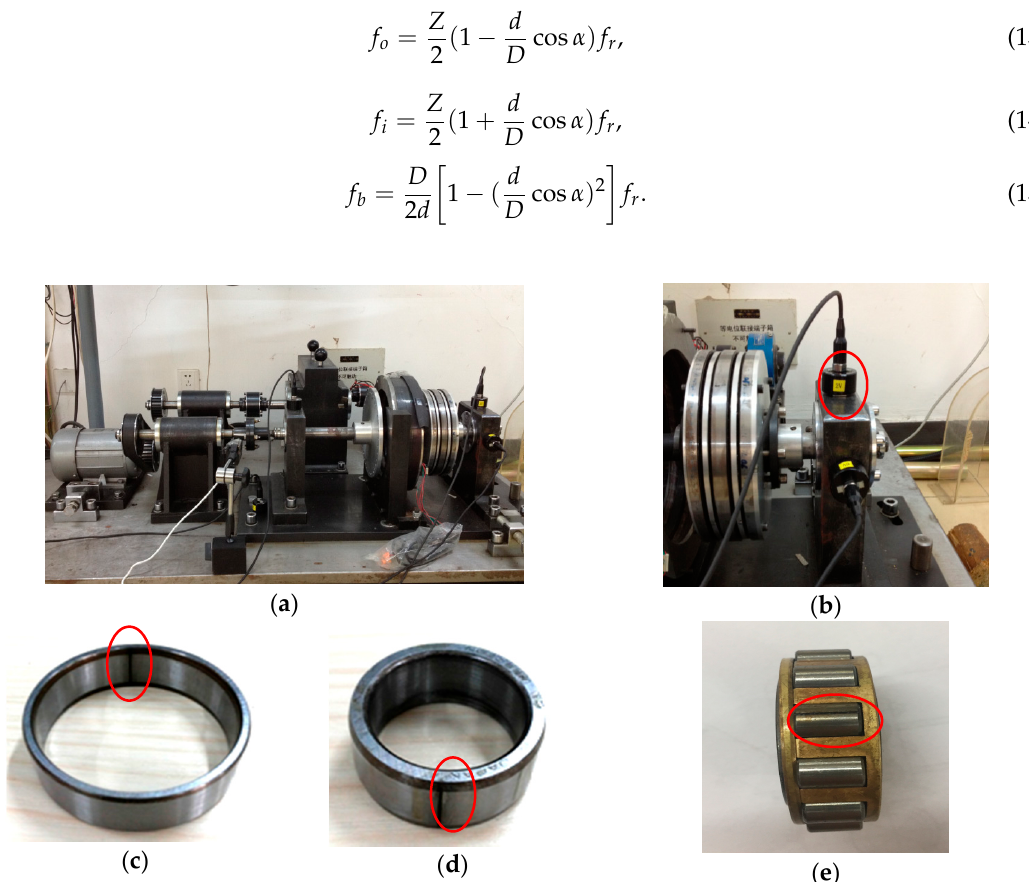
Figure 7. Experimental system for bearing diagnosis. ( a ) experiment table; ( b ) install location of the acceleration sensor; ( c ) outer-race and its flaw; ( d ) inner-race and its flaw; ( e ) roller and its flaw. Table 1. Structure parameters of NTN N204 bearing .